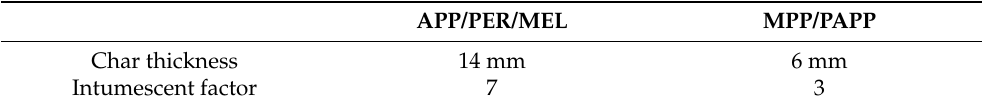
Table 3. Information on swelling char.